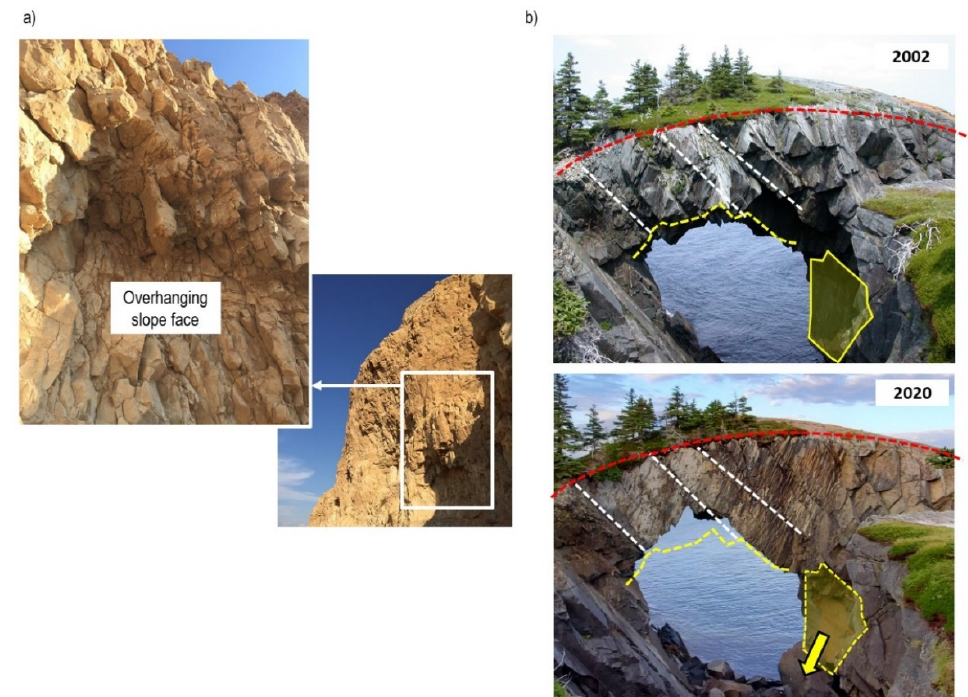
Figure 1. Examples of natural structures whose stability is controlled by the presence of rock bridges: ( a ) Masada fortress, Israel; and ( b ) Berry Head Arch, Canada, in 2002 and more recently in 2020.